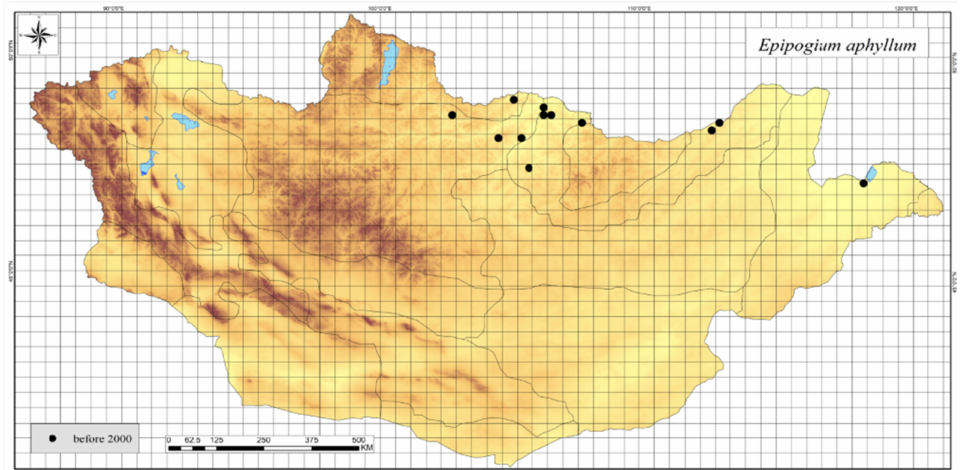
Figure A13. Distribution map of Epipogium aphyllum in Mongolia.